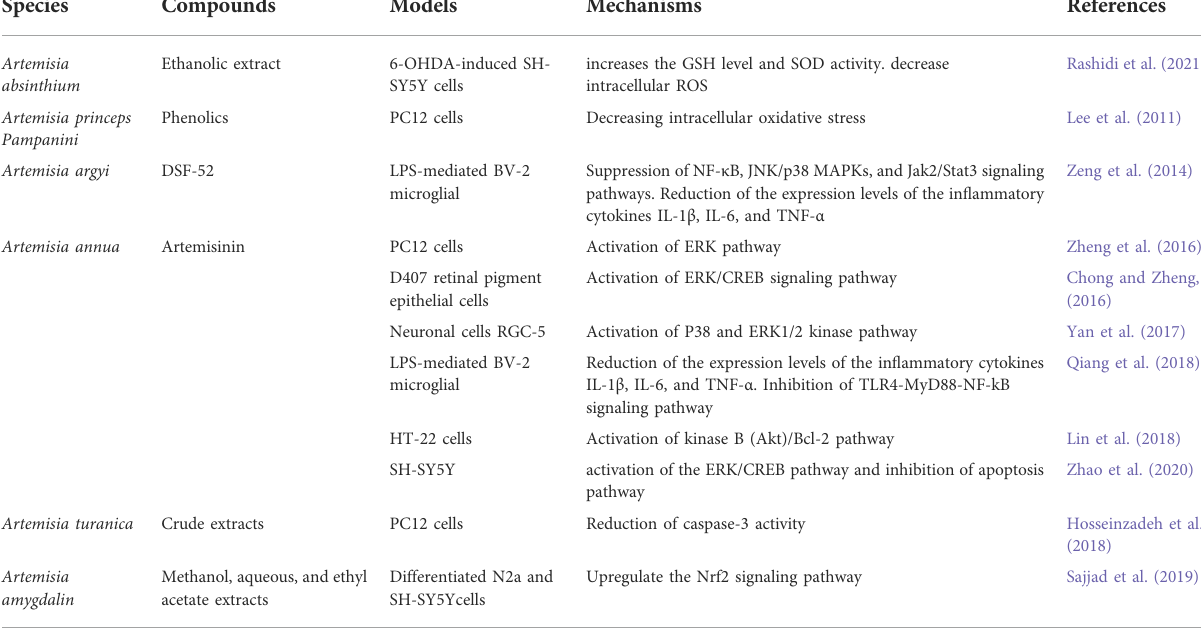
TABLE 3 Antioxidant, anti-in fl ammatory, and neuroprotective effects of Artemisia species in vitro and its mechanisms of action.